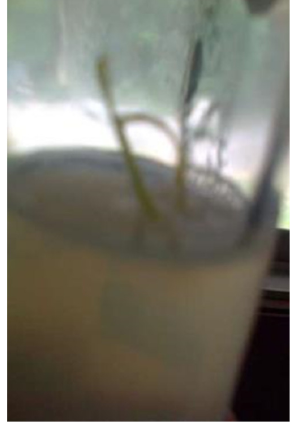
Figure 6: Acclimatized plantlets of E. cyclocarpum with thick roots Table 6. The effects of various concentrations of NAA, 2, 4-D alone or each separately combined with kinetin on morphology of callus from stem, cotyledon and nodal explants of E. cyclocarpum